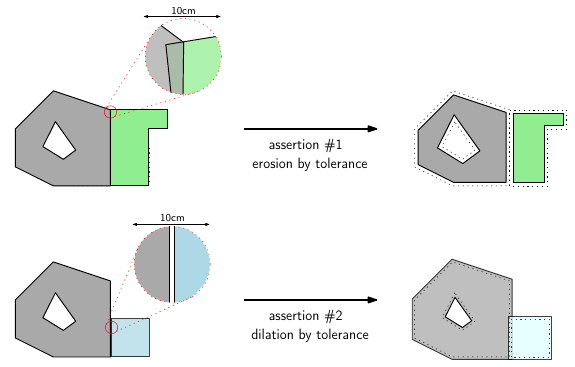
Figure 4. Example of how the tolerance is applied when verifying whether two gml:Solid s